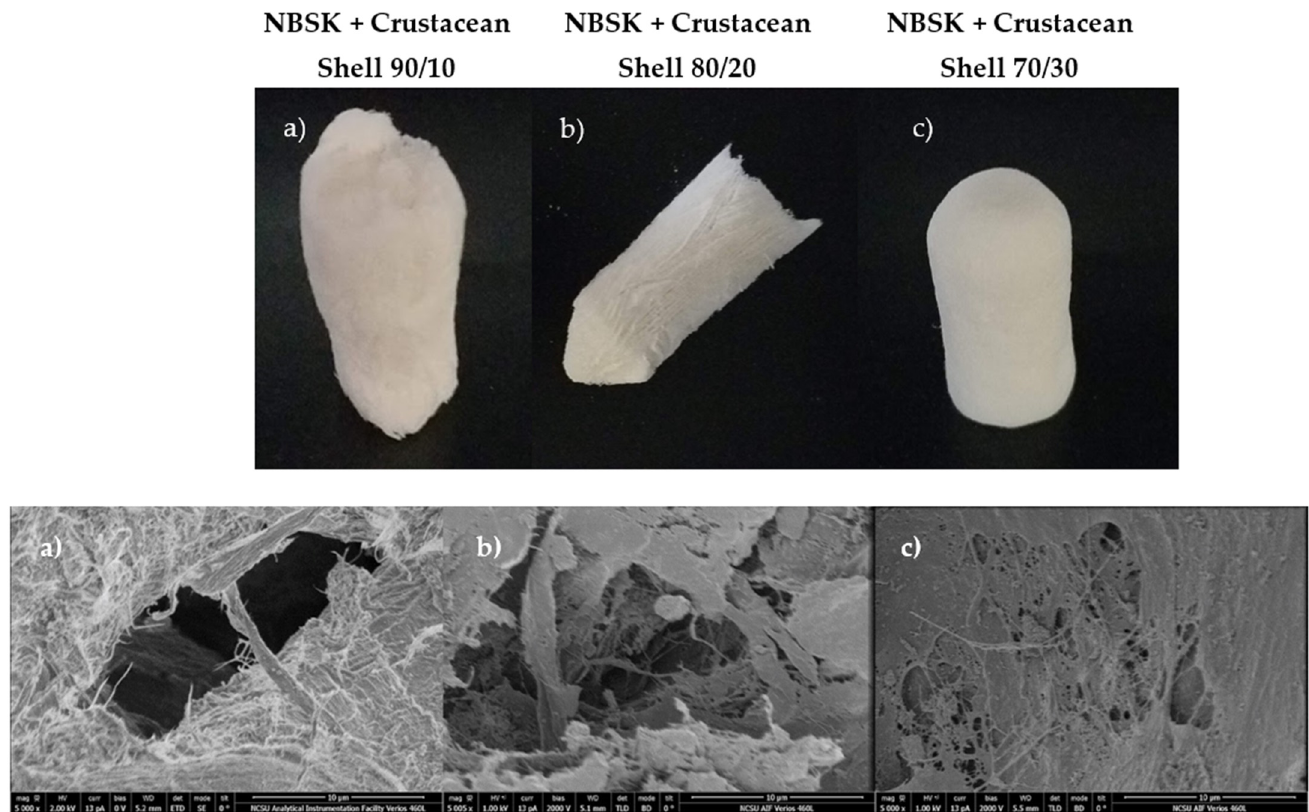
Figure 5. Cellulose-crustacean shell foams ( a – c ) represent gross (top) images and respective microscopic zooms (bottom): ( a ) NBSK+Crustacean Shell, 90/10, ( b ) NBSK+Crustacean Shell, 80/20, ( c ) NBSK+Crustacean Shell, 70/30, and accompanying SEMS (10-micron bar scale) formed by material co-grinding shown above followed by their respective SEM photomicrographs below the three images. Note the open porous structures which demonstrate the lack of fiber